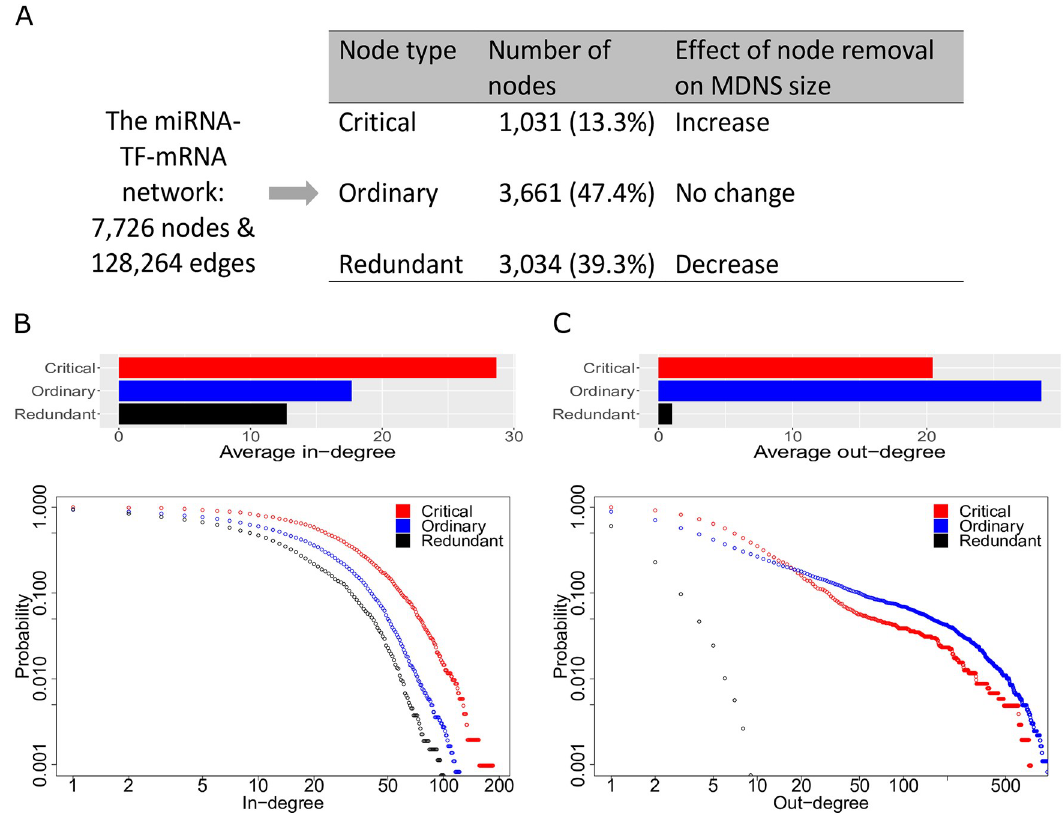
Fig 4. Characterising the controllability of the miRNA-TF-mRNA network. (A) Identification of critical, ordinary, and redundant nodes in the network. (B) Average in-degree and accumulative in-degree distribution (i.e. the in-degree i with the probability p means that the probability to pick a node which has in-degree larger than or equal to i is p) for three different node types. (C) Average out-degree and accumulative out-degree distribution for three different node